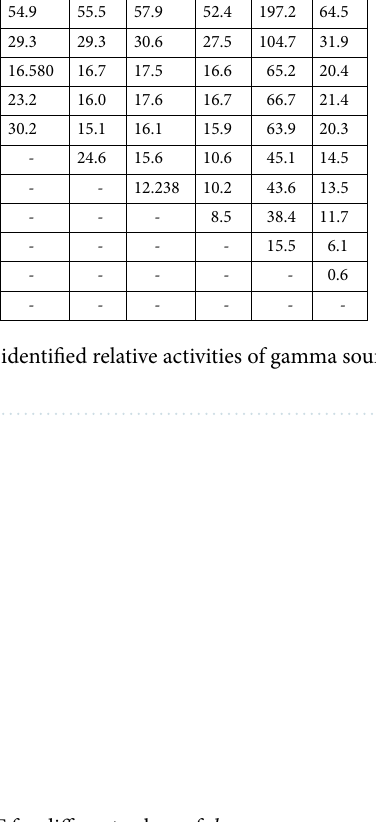
Table 7. Calculated values of d / d h and Γ for different values of d